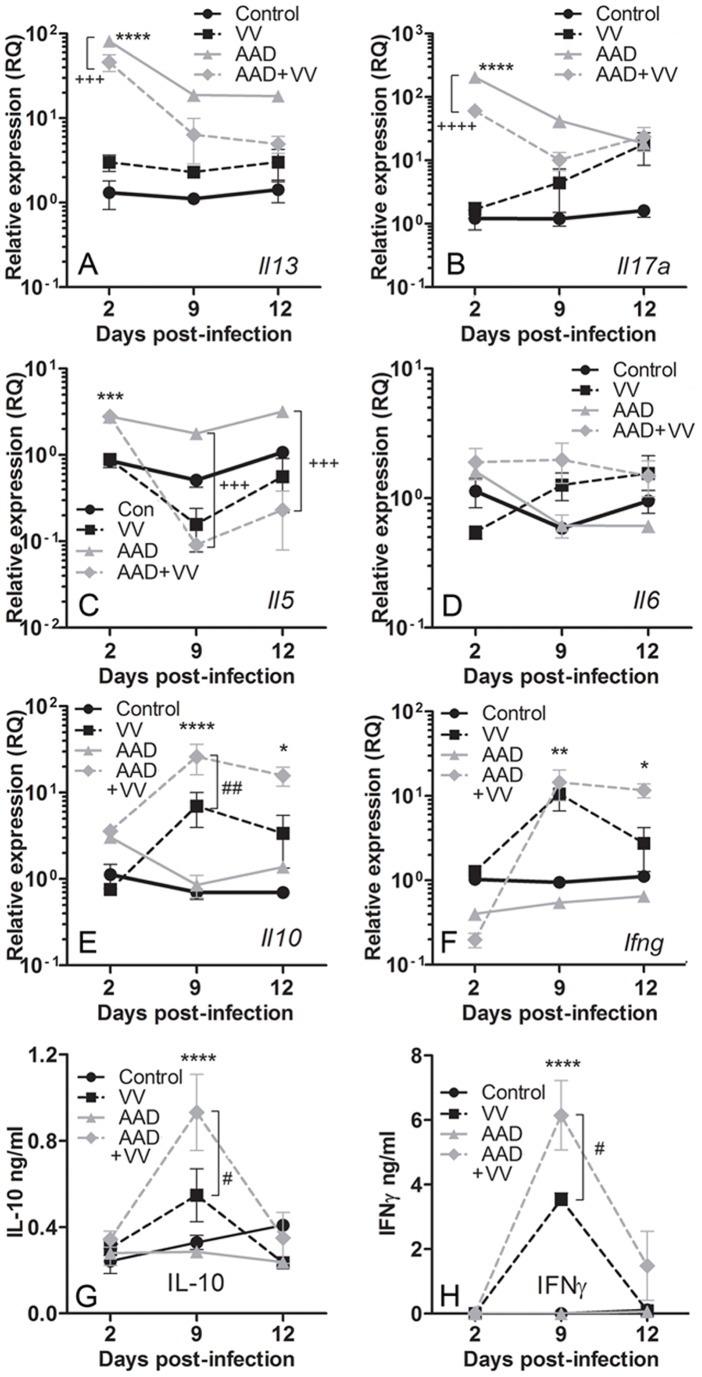
Induction of AAD and pulmonary VV inoculation altered expression of cytokines in the lungs.Relative expression of gene transcripts in lung tissue was measured using qRT-PCR. Transcripts for pro-allergic cytokines (A) Il13, (B) Il17a and (C) Il5, but not (D) Il6, were increased in AAD and VV-infected AAD mice. Transcripts for (E) Il10 and (F) Ifng were elevated in VV-infected mice and VV-infected AAD mice. In VV-infected mice, (G) IL-10 and (H) IFNγ secretion in BAL fluid peaked by 9 dpi, as measured by ELISA. AAD mice inoculated with VV secreted more IL-10 and IFNγ at 9 dpi compared to non-allergic mice infected with VV. Data are expressed as the mean ± SEM for four mice in each group. Data are representative of 2 independent experiments. Statistical significance was determined by a Two-way ANOVA with Bonferroni’s multiple comparisons test: *P<0.05, **P<0.01, ***P<0.001, ****P<0.0001 AAD+VV vs. control; #
P<0.05, ##
P<0.01 AAD+VV vs. VV; +++
P<0.001, ++++
P<0.0001 AAD+VV vs. AAD.